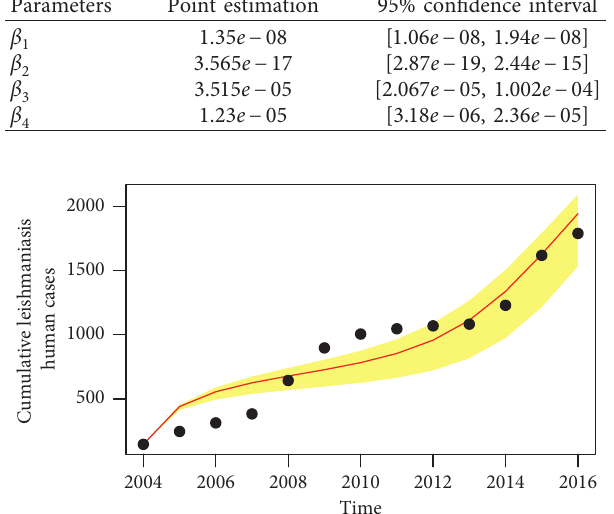
Figure 3: Cumulative incidence simulation of VL in Kashgar from 2004 to 2016.